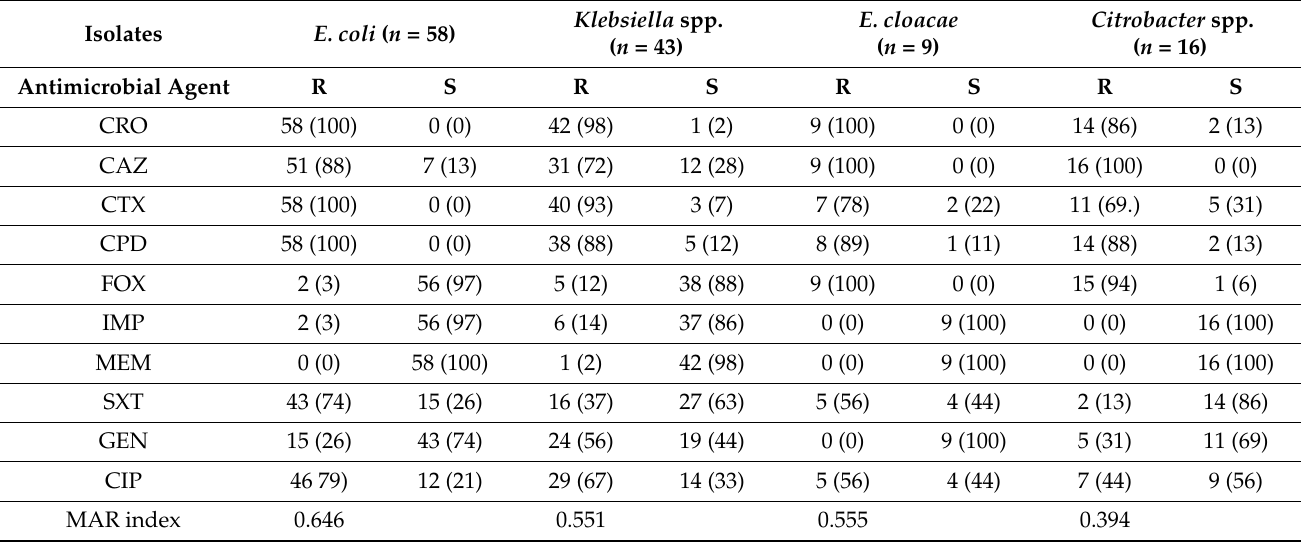
Table 3. Antimicrobial susceptibility of each genus in percentage and their multiple antibiotic resistance indices ( n =